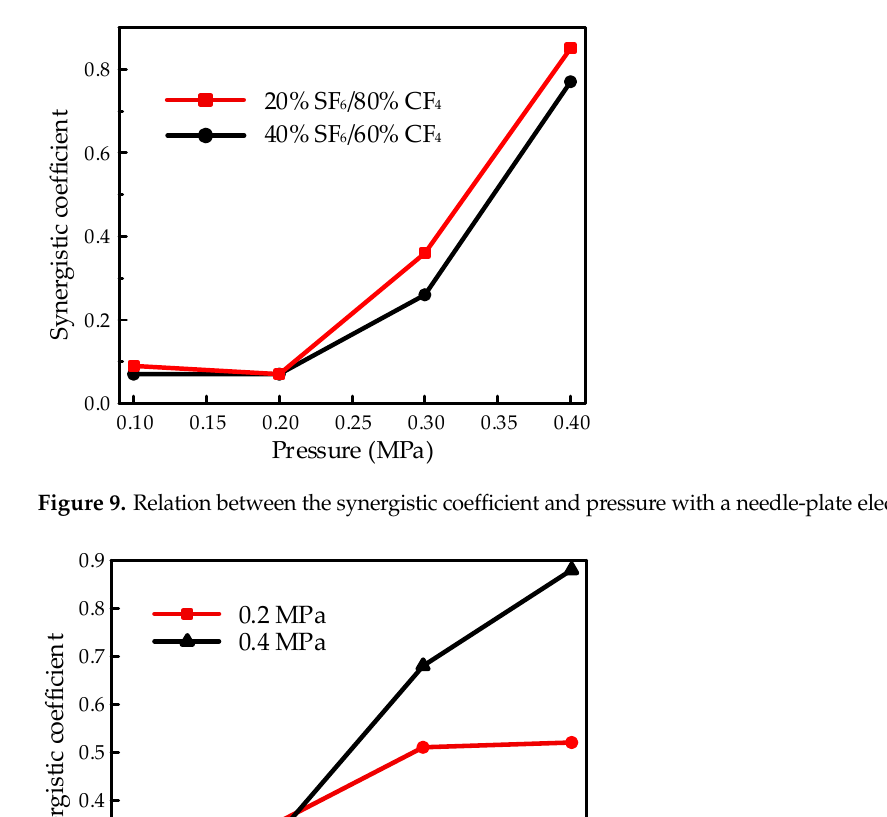
Figure 10. Relation between the synergistic coefficient and the content of SF 6 with a finger-type elec-